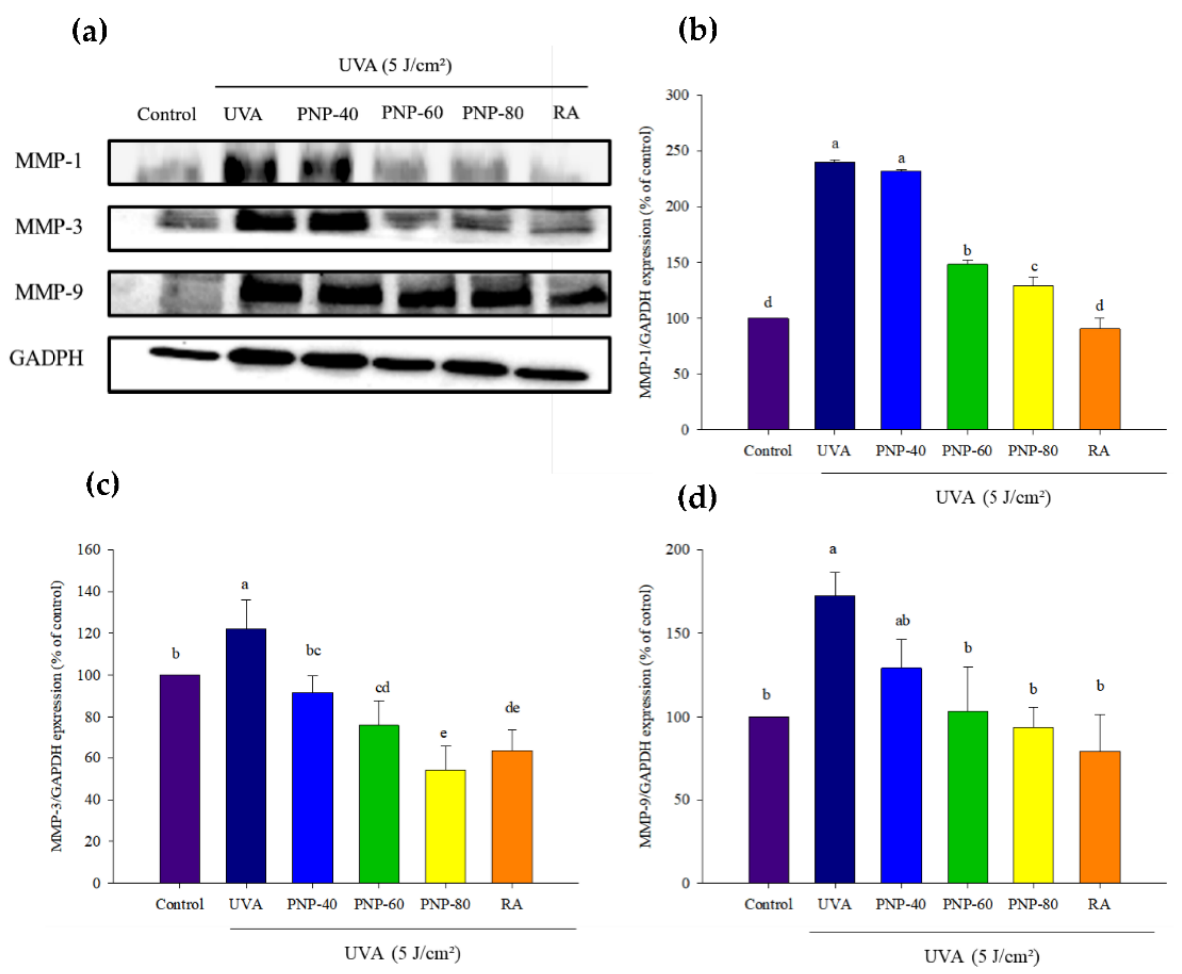
Figure 7. Protective effect of PNPs against UVA irradiation in Hs68 cells. Protein expression of MMP-1, -3, and -9 was analyzed via Western blot. ( a ) Hs68 cells were pretreated with PNPs (250 µg/mL) and RA (10 µM) for 24 h, followed by UVA-irradiation. Western blotting was performed to